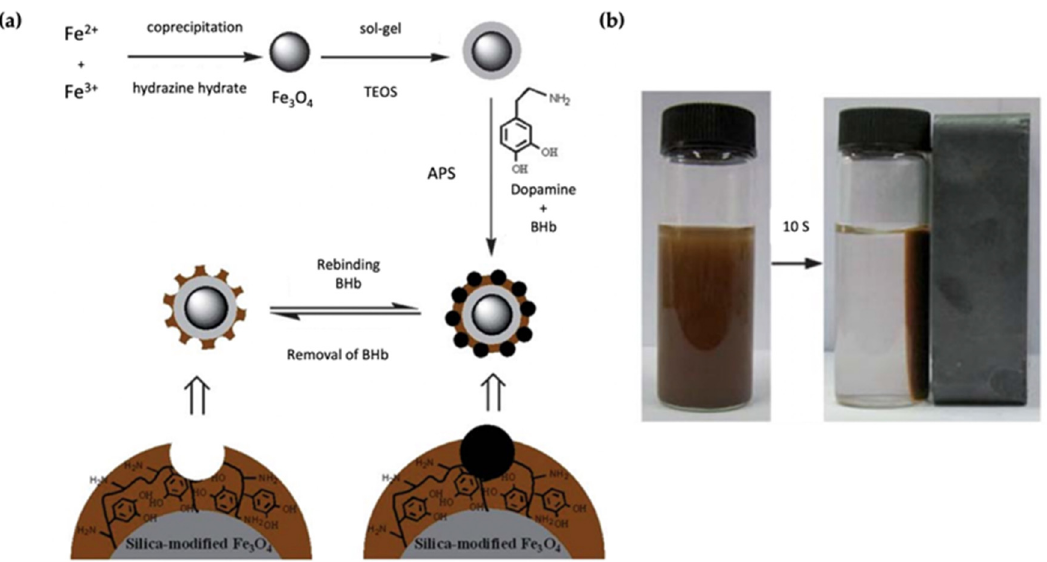
Figure 15. ( a ) General preparation of BHb imprinted SiO 2 @Fe 3 O 4 nanoparticles, ( b ) magnetic response of the nanoparticles in the presence of an external magnetic field. Reproduce with permis- sion from [102].